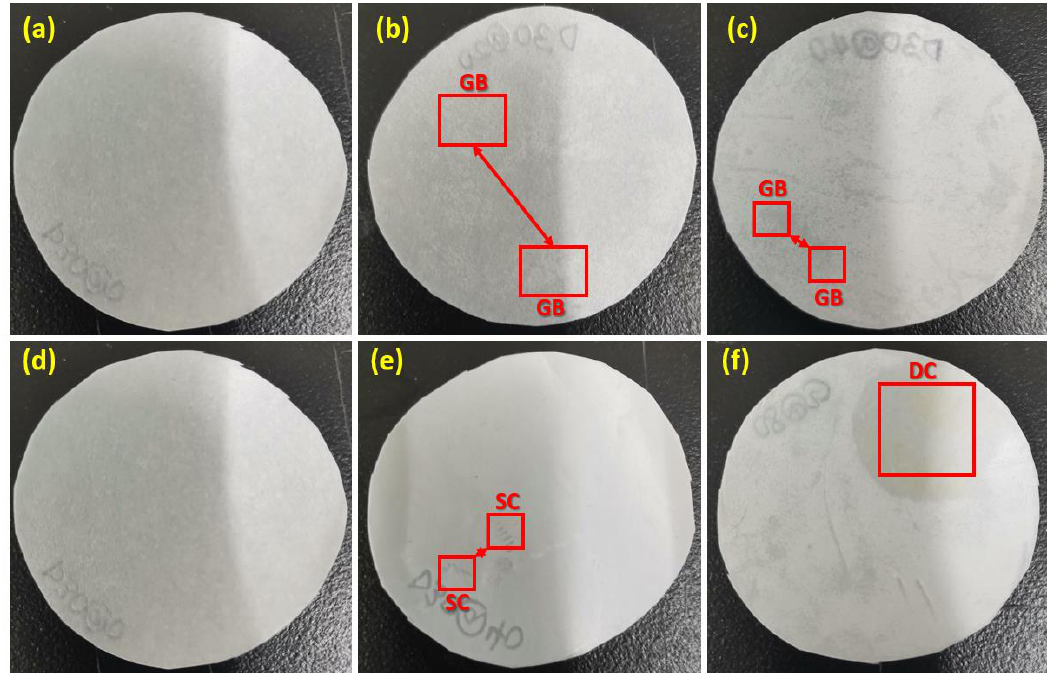
Figure 9. Physical inspection of the PVDF membranes at the end of exposure Day 7 for ( a ) neat membranes, ( b ) PVDF-1, ( c ) and PVDF-15, ( d ) and the end of Day 112 for neat membranes ( e ) PVDF-1 and ( f ) PVDF-15. Note: GB, SC and DC represent grouped blisters, slight cracks and discoloration, respectively.